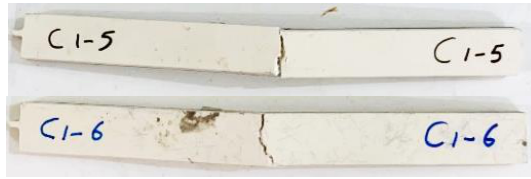
Fig. 12. Samples tested in